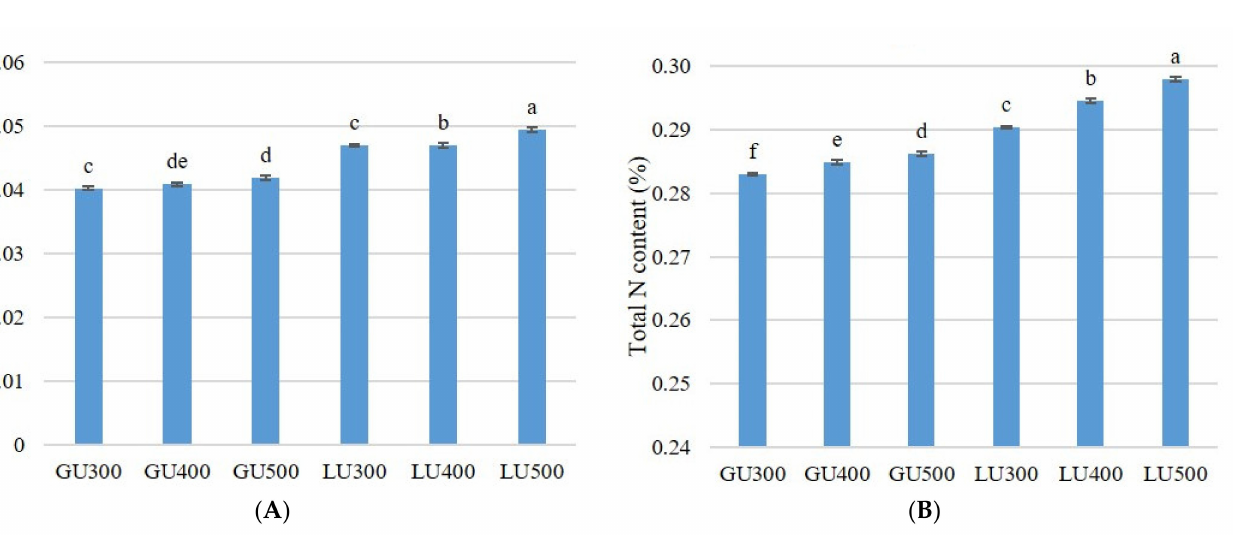
Figure 6. Total remaining N (%) in Bungor ( A ) and Selangor ( B ) soils applied with different rates of LU and GU fertilizers at the end of 30 days of incubation. Different letters indicate significant difference between means using least significant difference (LSD) test at the 5% significant level. Vertical bars on the graphs show the standard